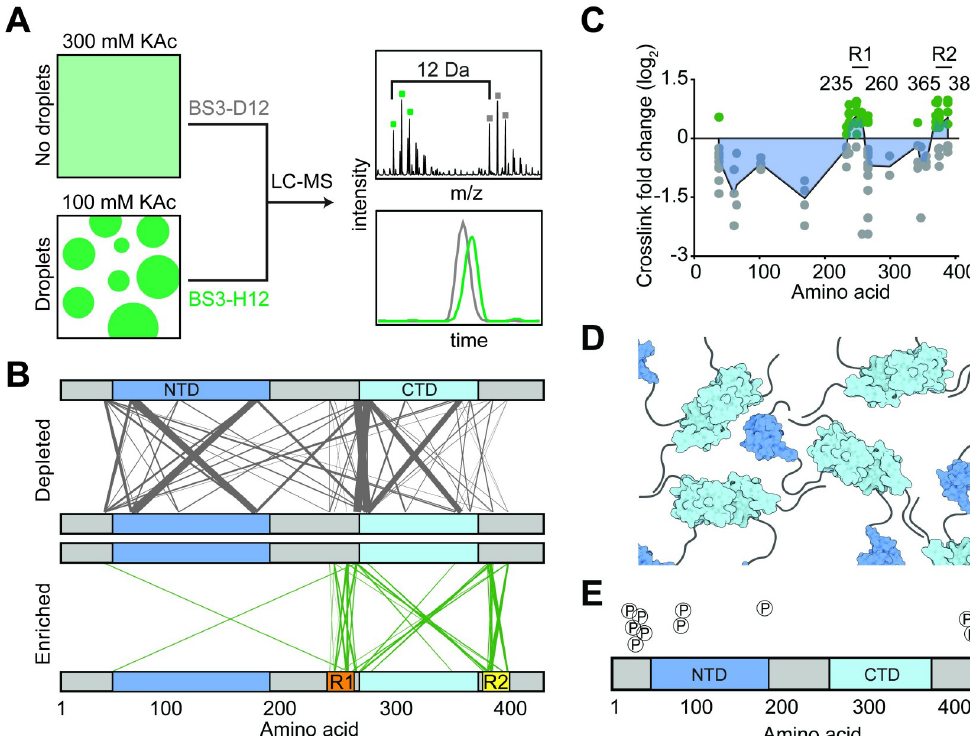
Fig 3. CLMS reveals interdomain interactions of the N protein. (A) Schematic of the CLMS experiment. (Left) A high salt (300 mM KAc) buffer disrupts N condensates, whereas a low salt (100 mM KAc) buffer promotes condensate formation. (Right, top) Example of an individual cross-linked peptide in quantitative CLMS analysis. Precursor ions from the high salt (gray) and low salt (green) BS3 cross-linking conditions show the 12 Da shift between light (H12) and heavy (D12) cross-linkers. (Right, bottom) Ion chromatograms from the first 3 isotopes of each doublet were extracted and expressed as the ratio of peak areas. (B) The plot of cross-links depleted and enriched in the condensate condition. The width and transparency of the lines scale with the number of times the cross-link were detected across 3 independent experiments. (C) Fold changes of cross-link abundance upon condensate formation of N. As cross-links contain 2 positions, fold change information is plotted at both positions. Only cross-links with p -values less than 0.05 are included. Green and gray dots represent cross-links enriched and depleted in the condensate condition, respectively. The blue area represents a plot of median cross-link fold change. Data underlying this figure can be found in S1 Table. (D) Model for how multiple N dimers could phase separate via their disordered regions. (E) Phosphorylation sites detected by the CLMS experiment in 300 mM KAc. CLMS, cross-linking mass spectrometry; CTD, carboxyl-terminal domain; N, nucleocapsid; NTD, N-terminal